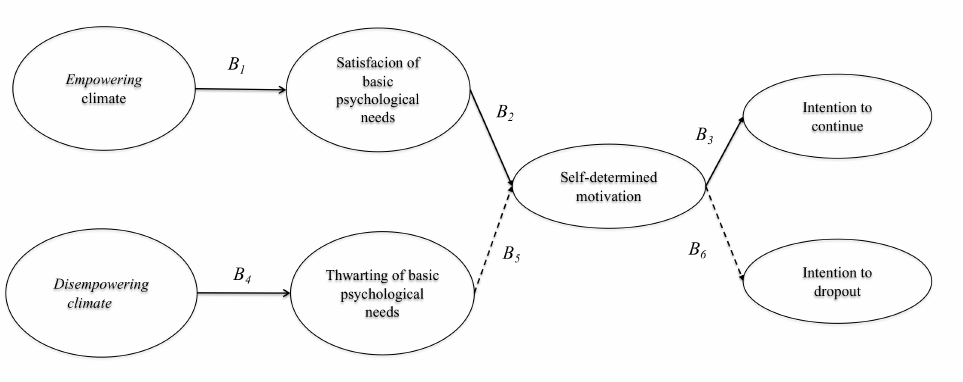
Figure 1. Graphic representation of the hypothetical model (M1). Note: Solid lines represent positive relationships and dashed lines negative